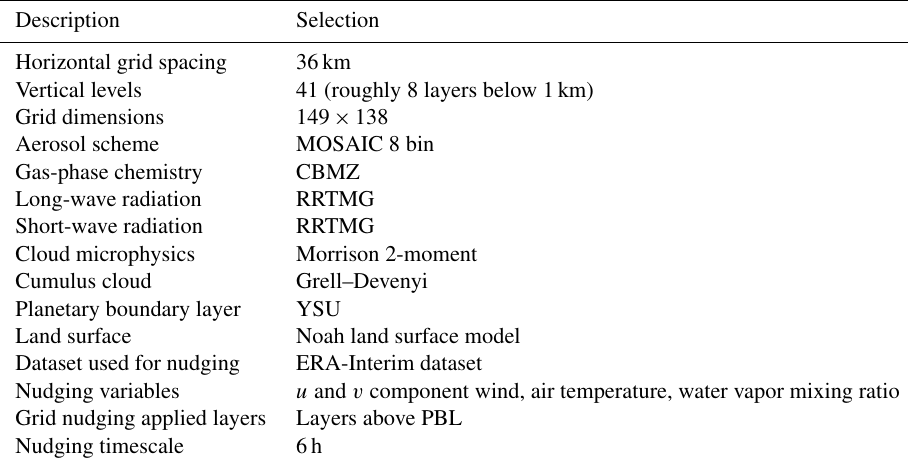
Table 1. Summary of model